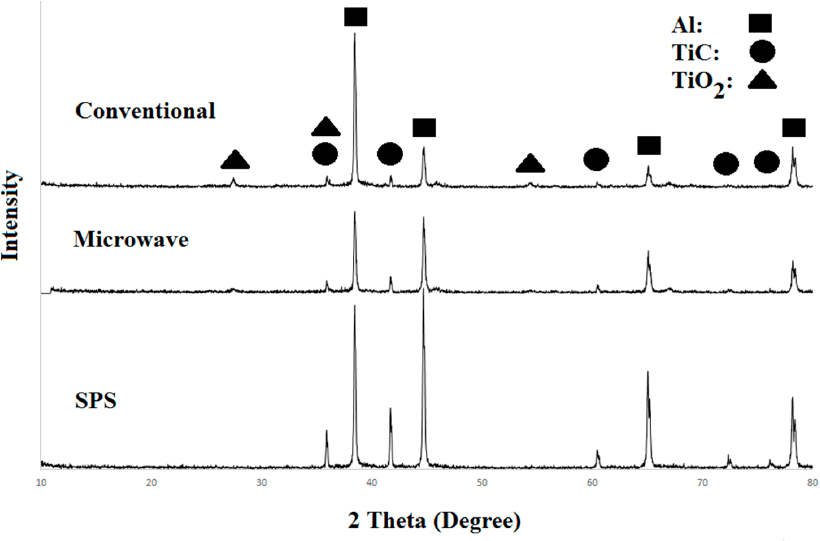
Figure 1. XRD (X-ray diffraction) patterns of SPS (speak plasma sintering), microwave, and conventional samples sintered at 400 °C, 600 °C, and 700 °C.